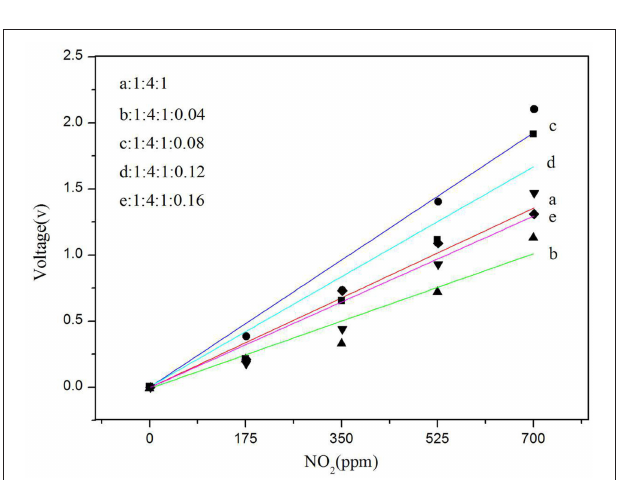
FIGURE 9 | Dependence of sensor voltage on NO 2 concentration for different MWCNT (Sample b, c, d, and e) contents in SPE and solid electrolyte without MWCNT as a blank control (sample